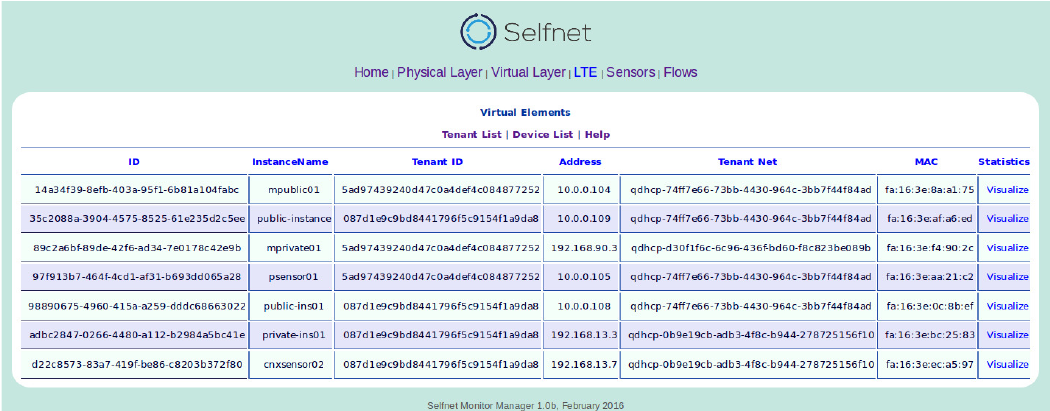
Figure 18. List of SELFNET virtual elements on the Virtual Layer View.